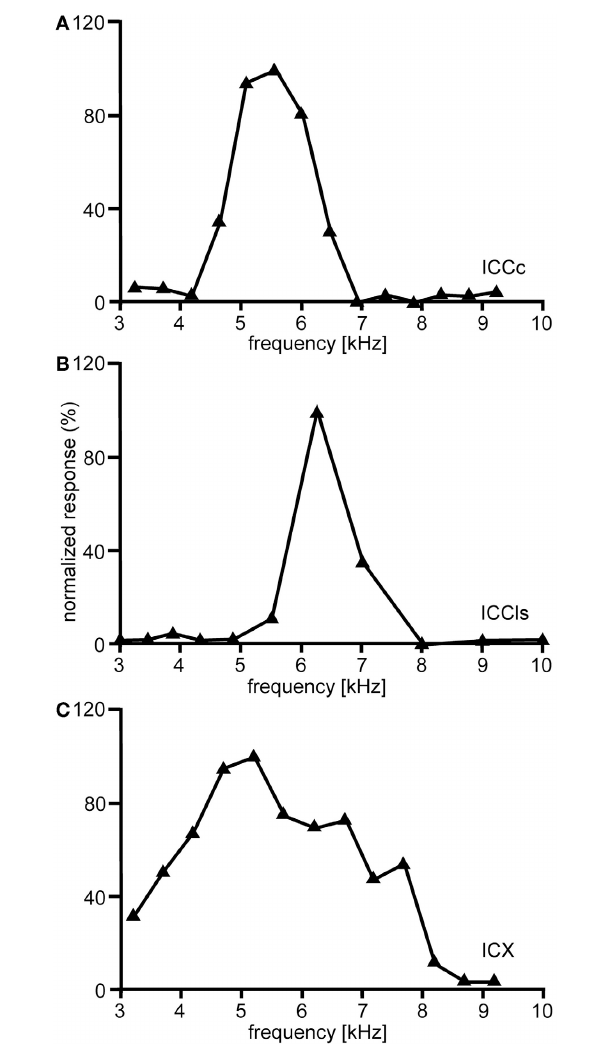
FIGURE 5 | Frequency tuning. Shown are examples of the variations of the normalized responses with frequency of neurons located in different nuclei of the IC. In ICCc frequency tuning is narrow (A) . A similar tuning is observed in the cells of ICCls (B) . By contrast frequency tuning of the cells of the ICX is broader than in ICC (C)